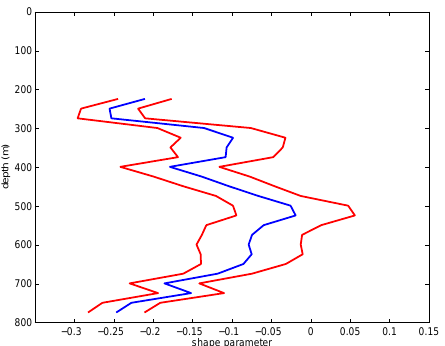
Fig. 3. Variation of the shape parameter (blue) and 95% confidence interval (red) with depth. The values of the shape parameter were obtained by fitting the GEV distribution to daily maxima at each available depth, at location